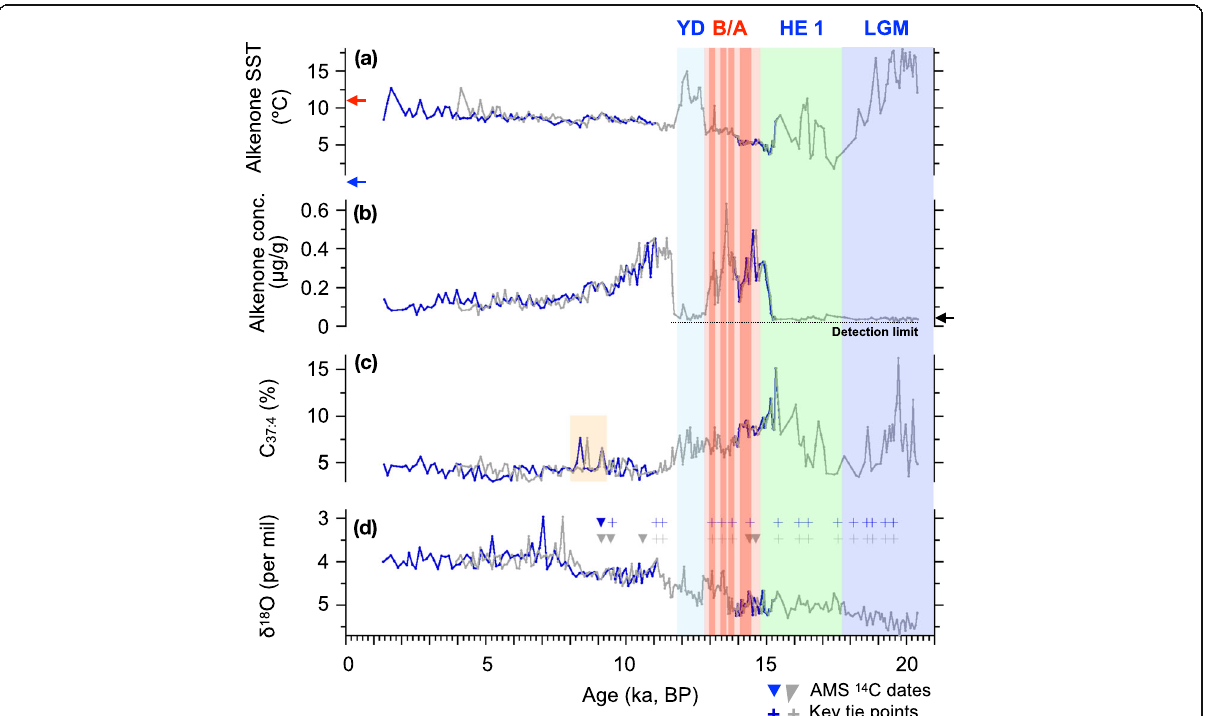
Fig. 2 Downcore LV 63-41-2 alkenone proxy-based estimates since the last glacial. a U k ’ 37 -SST, b alkenone concentration (or total C 37 ), and c C 37:4 freshwater index, all are plotted against age and compared to d published downcore δ 18 O stratigraphy and chronology (Gorbarenko et al. 2017; this study). Records applied in different chronologies from Gorbarenko et al. (2017, 2019), and this study is indicated by blue and gray, respectively. Age differences between those two chronologies are minor on late HE 1 – early B/A and late – middle Holocene, except for late Holocene. Shaded intervals indicate LGM, stadial HE 1, B/A (sub)-interstadials, and YD. Modern summer and winter SSTs are indicated, respectively, by red and blue arrows on a . Also, ~ 9 – 8 ka events mentioned in this text are also shaded in c . Prior to HE 1, our mean alkenone concentration (0.038 ± 0.008 μ g/g) and detection limit of measuring the alkenone concentration (0.02 μ g/g; Seki et al. 2004a) are indicated, respectively, by a black arrow and dashed line in